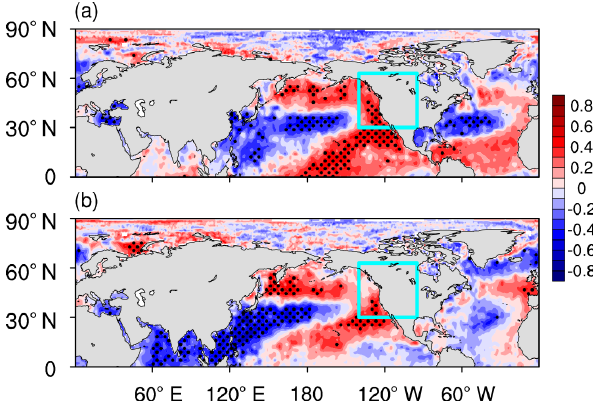
Figure 8. (a) Correlation coefficients between regional precipita- tion (43–50 ◦ N, 115–130 ◦ W) and SST variations in April for 1984– 2016. (b) Correlation coefficients between March ASO (ASO mul- tiplied by − 1) and April SST variations for 1984–2016. Dots denote significance at the 95% confidence level, according to Student’s t test. Before performing the analysis, the seasonal cycle and lin- ear trend were removed from the original data. ASO data are from SWOOSH, precipitation from GPCP and SST from